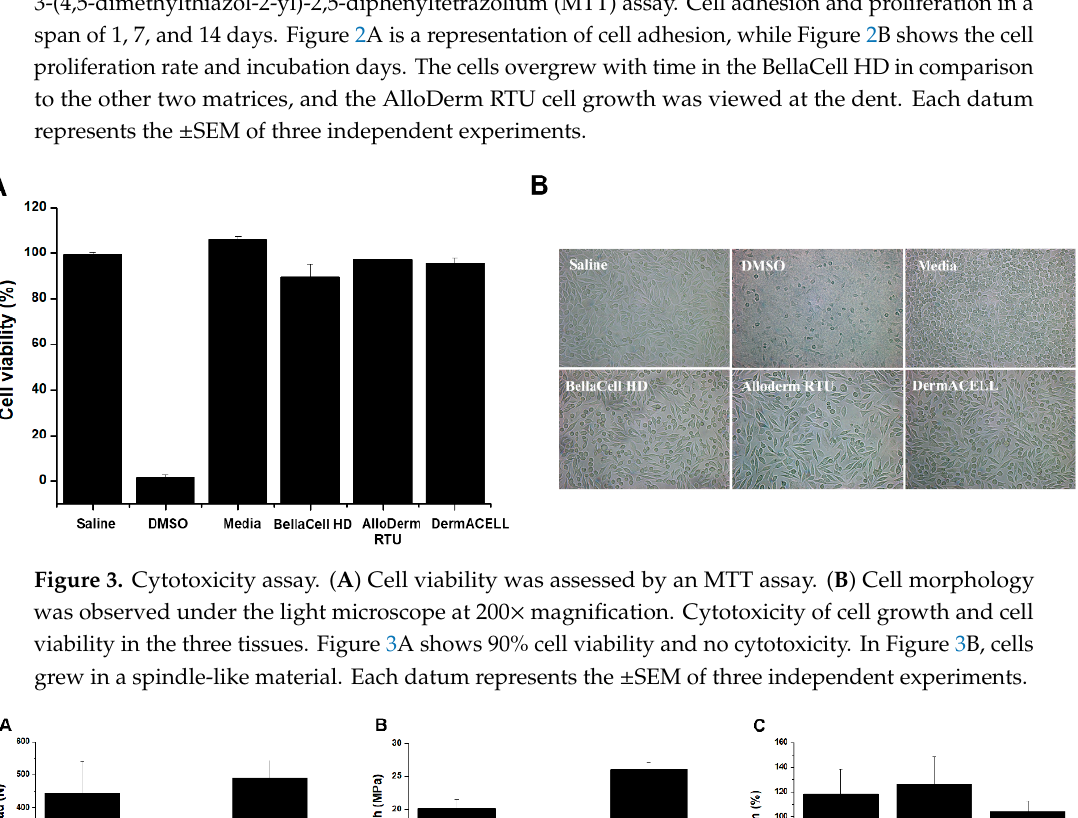
Figure 3. Cytotoxicity assay. ( A ) Cell viability was assessed by an MTT assay. ( B ) Cell morphology was observed under the light microscope at 200× magnification. Cytotoxicity of cell growth and cell viability in the three tissues. Figure 3A shows 90% cell viability and no cytotoxicity. In figure 3B, cells grew in a spindle-like material. Each datum represents the ±SEM of three independent experiments. Figure 4. Uniaxial tensile test. ( A ) Maximal load, ( B ) tensile strength, and ( C ) elongation. Figure 4A shows the 444.94 N break for BellaCell HD, AlloDerm RTU 181.92 N, and 492.11N for DermACELL. The tensile for the BellaCell HD, Alloderm RTU, and DermACELL is 22.44 MPa, 14.34 MPa, and 26.12 MPa (Figure 4B). Figure 4C represents the elongation ratio of 118.41%, 126.38%, and 104.13% for BellaCell HD, Alloderm RTU, and DermACELL products, respectively. Each datum represents the ±SEM of three independent experiments.